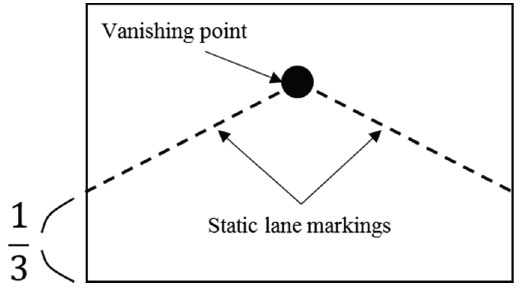
Figure 6. Static lane markings.